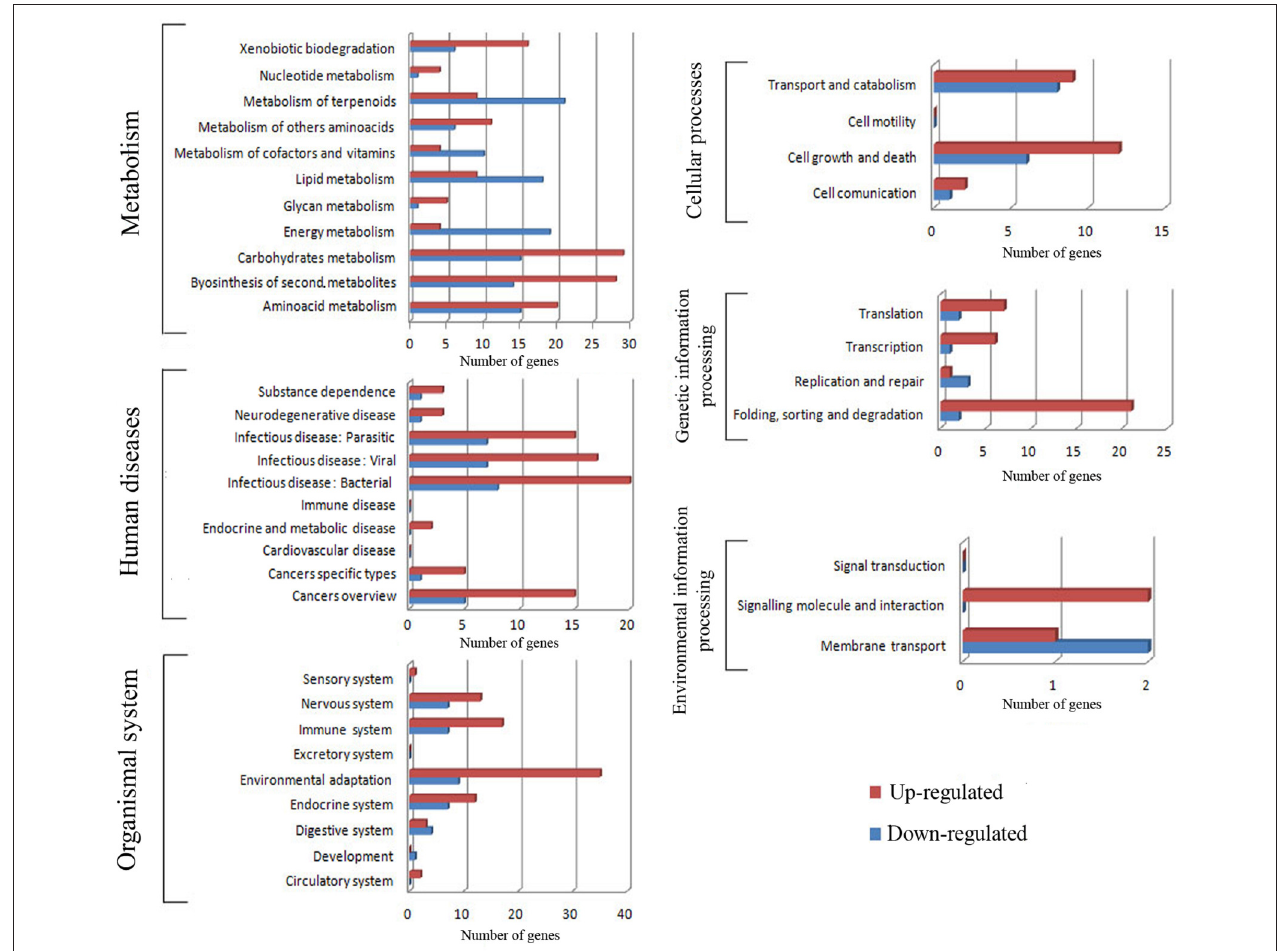
FIGURE 4 | Pathway subclassification for cold stress responsive genes for each KEGG category.